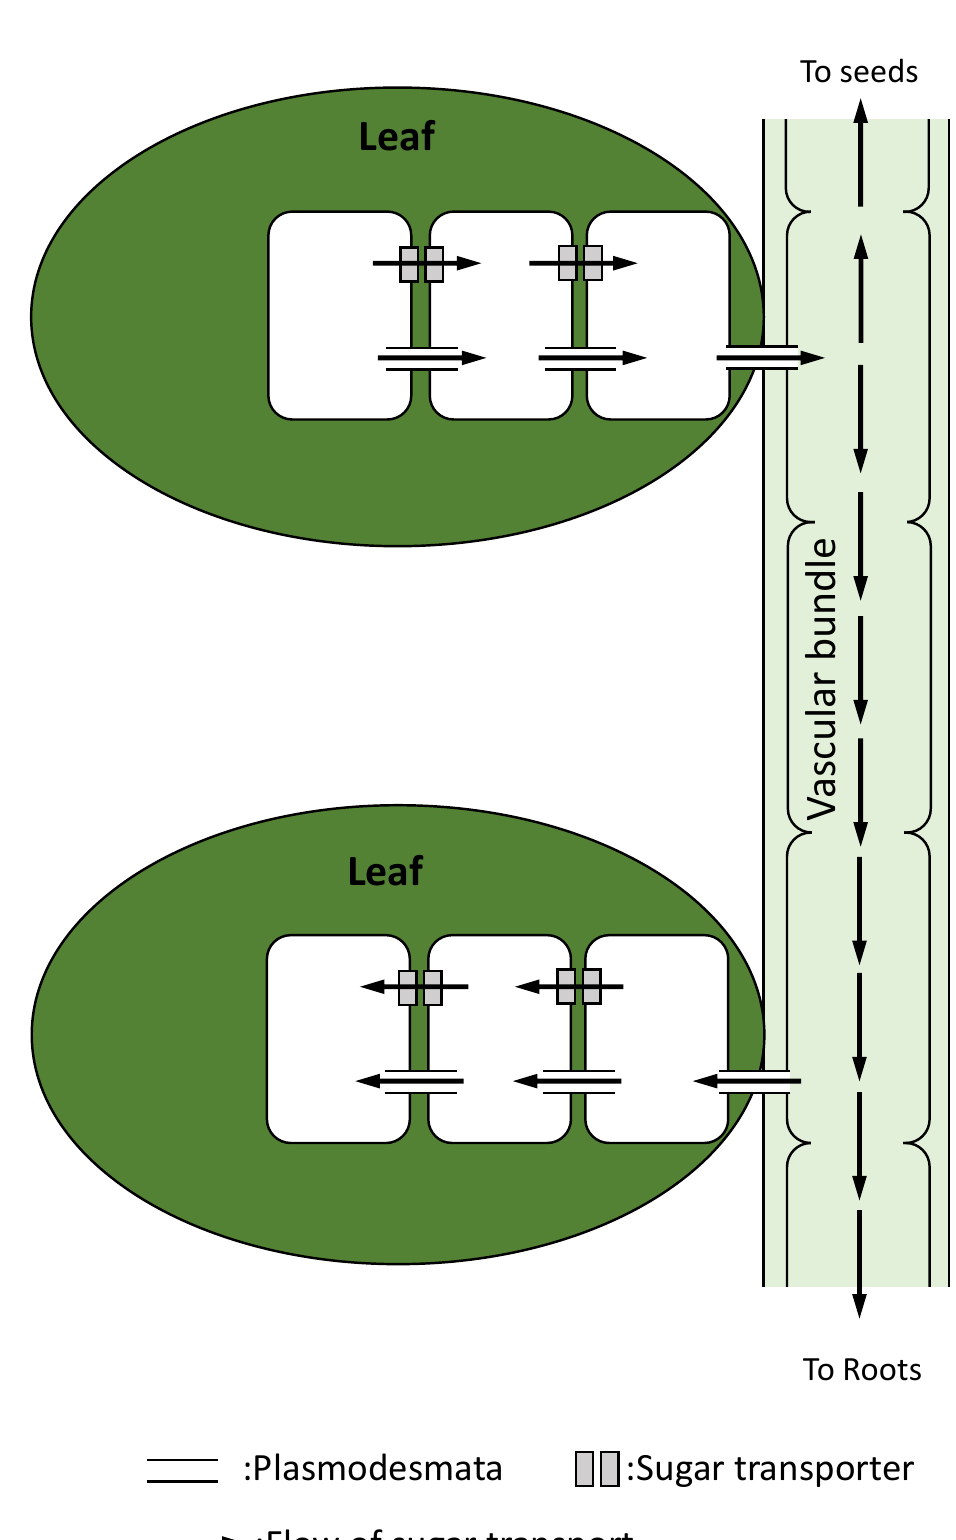
Figure 5. Sugar transport via cell-to-cell communications. Sucrose synthesized in a leaf can be transported through multiple cells via plasmodesmata or transporters, and it leaches to a vascular